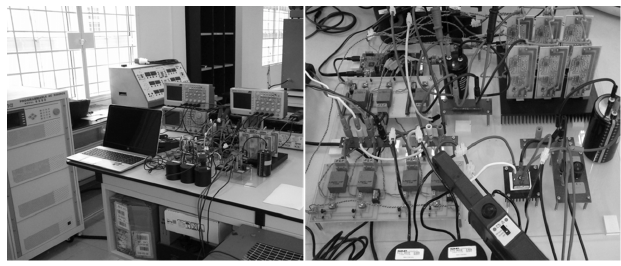
Figure 15. Experimental setup.